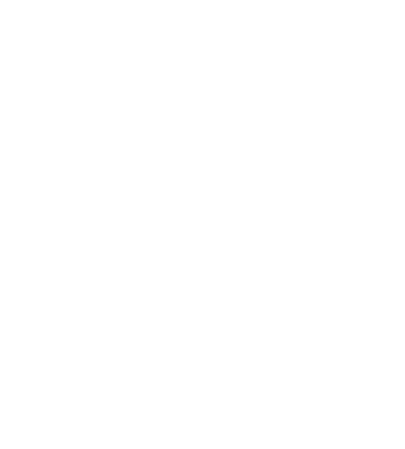
Figure 6. The Relative Corrected Rotation Speed Growth Rate Comparison between AFS and CDFS.